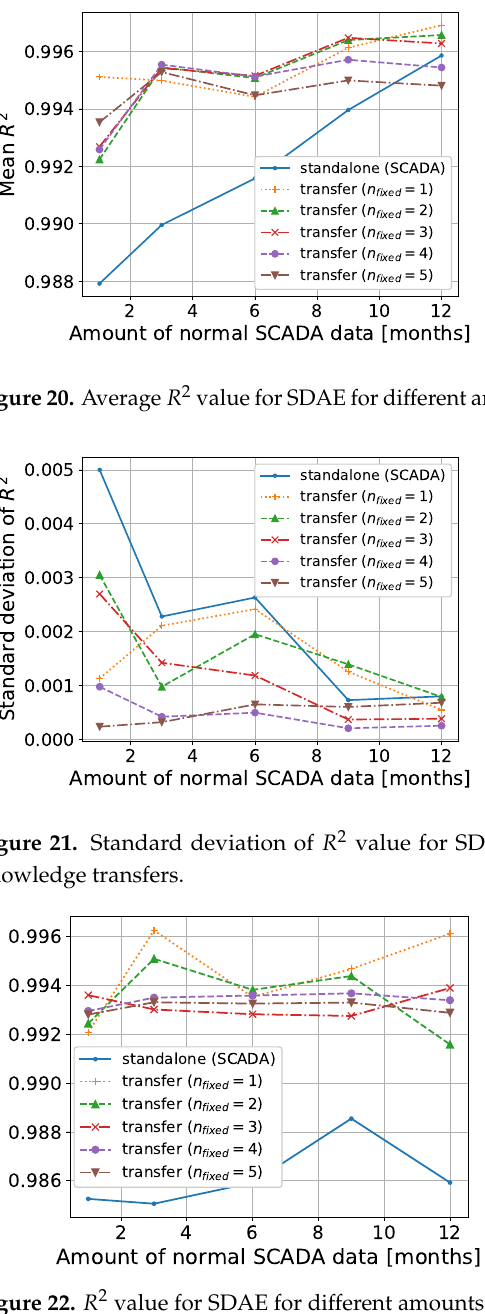
Figure 22. R 2 value for SDAE for different amounts of training data and knowledge transfers tested on same 3 months test